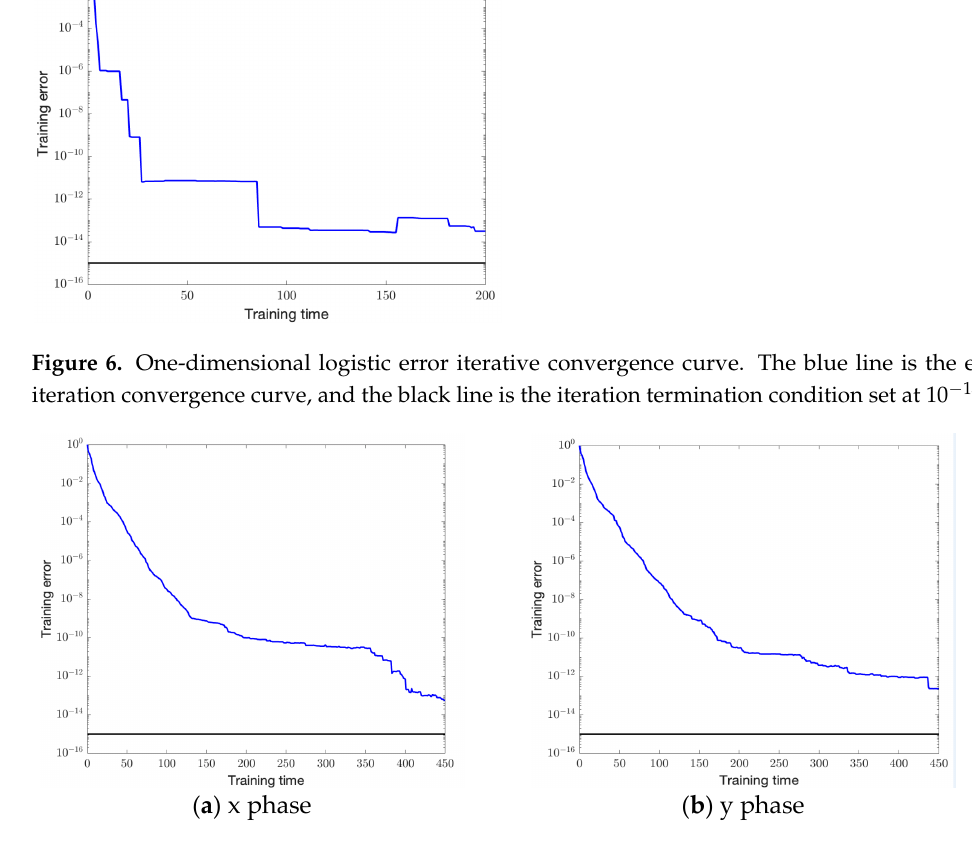
Figure 7. Two-dimensional Henon error iterative convergence curve. The blue line is the error iteration convergence curve, and the black line is the iteration termination condition set at 10 − 15 .